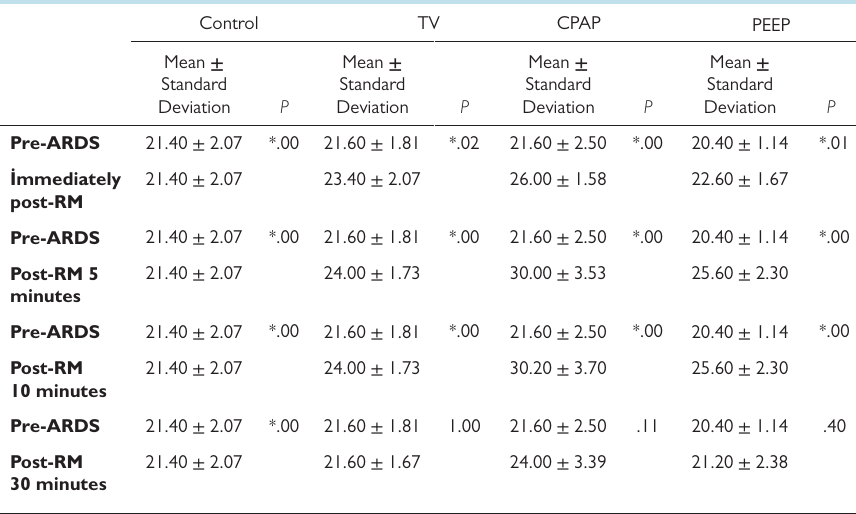
Table 2. ICP Values of the Groups Pre- and Post-ARDS Control